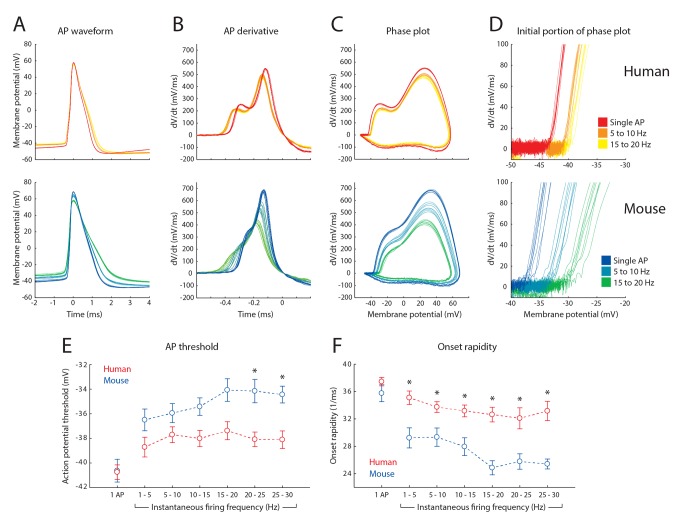
Fast AP onsets are maintained during repeated firing in human pyramidal neurons.(A–D) Waveforms and derivatives of APs recorded from a human (top traces) and mouse pyramidal neuron (bottom traces). Different colors correspond to APs with different instantaneous firing frequencies (see inset, (D)). (A) AP waveform in time (ms) aligned to timing of the AP peak. (B) First derivative of rising phase of AP, aligned to timing of AP peak. (C) Phase plot of APs with the AP derivative dV/dt versus membrane potential (mV). (D) Magnification of initial portion of phase plot shown in (C). (E) Summary data of average AP threshold of human (red; n = 23) and mouse (blue; n = 12) neurons, displayed versus firing frequency. Data are presented as means ± SEM for single APs, and APs fired in trains binned in 5 Hz bins according to instantaneous firing frequency. Asterisks indicate p<0.005. (F) Same as (E), for average AP onset rapidity. (Data deposited in the Dryad repository, http://doi.org/10.5061/dryad.3723p
[56]: Raw data underlying (A–F) as well as Figure S4 in Data_Fig5_and_SFig4.rar; Numerical data that generated (E) and (F) as well as Figure S4 in Data S5.xlsx).